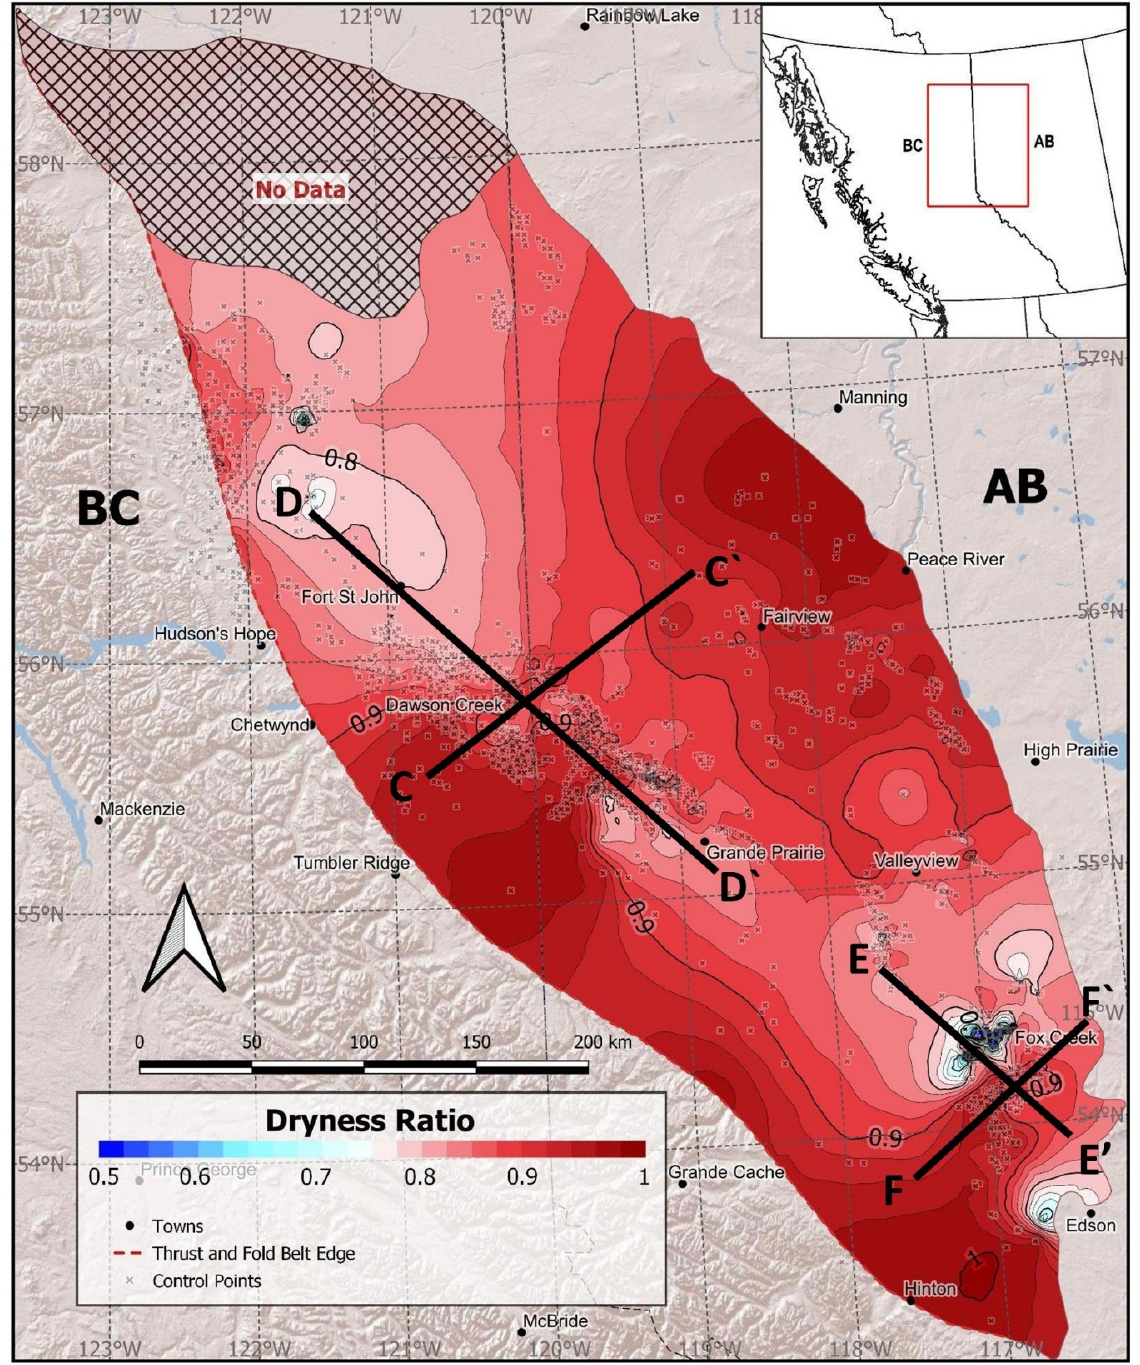
Figure 24. Distribution of gas dryness ratio on the entire Montney Formation. The wetter region at Fox Creek in the SE of the map is the conventional Montney coquina reservoir in the Kaybob oilfield. This is part of the bioclastic shoreline succession [11] of the Montney Formation and highlights the diverse range of reservoir types in the Montney Formation. The map shows the location of cross- sections C–C ′ , D–D ′ , E–E ′ , and F–F ′ (Figures 30–33).